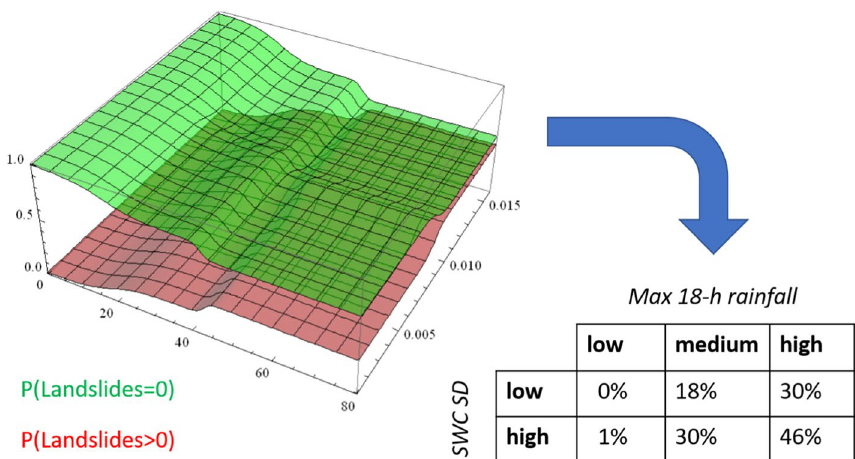
Fig. 5 Probability of landslide and non-landslide associated with the model that com- bines the maximum of the 18 h cumulated rainfall and the standard deviation of the water